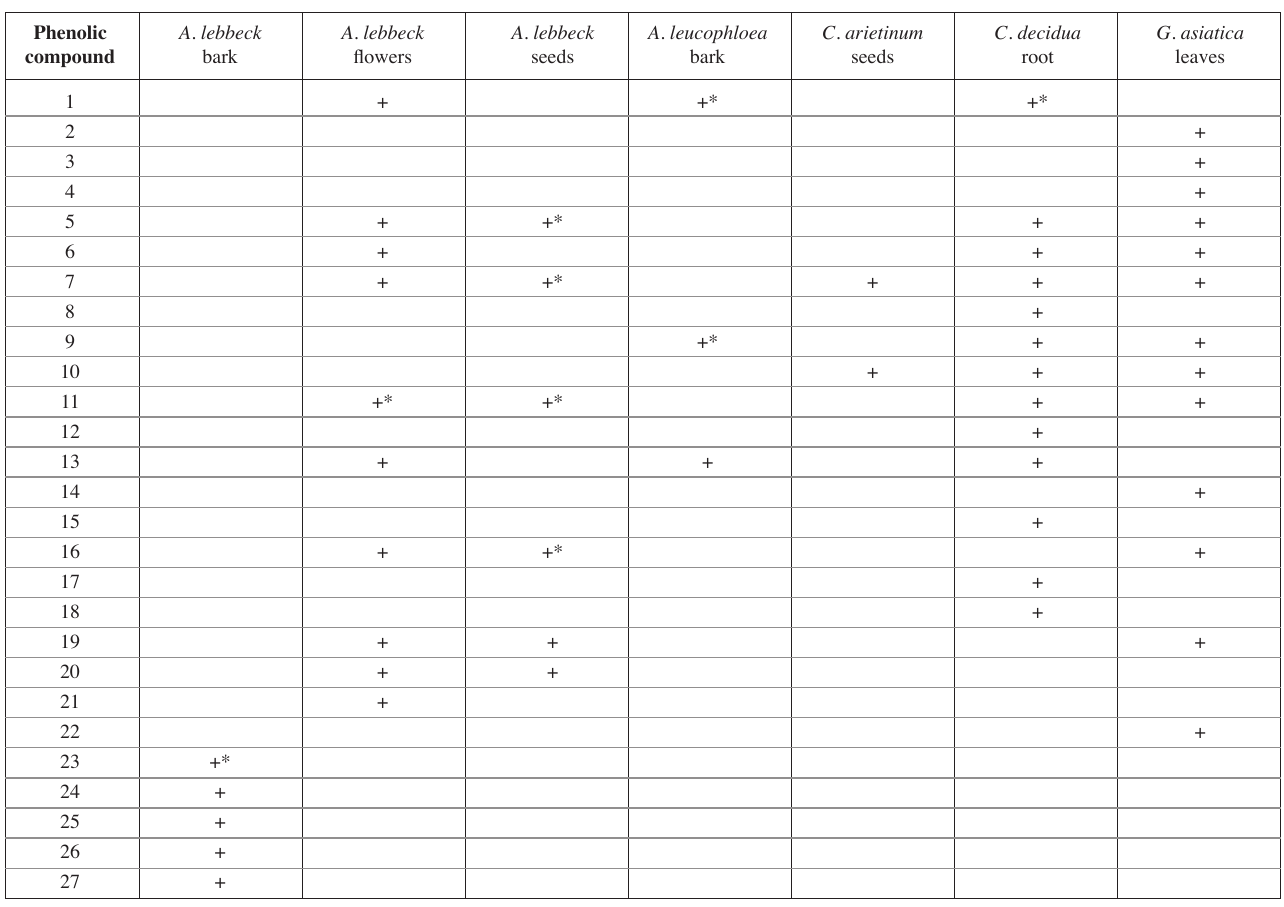
Tab. 3: Phenolic profile of plant extracts Phenolic